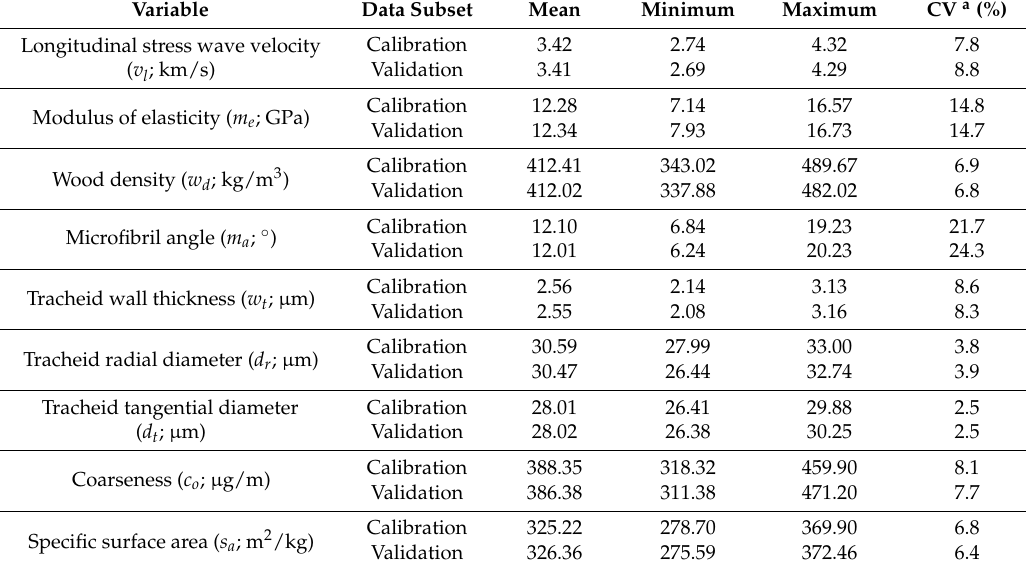
Table 6. Descriptive statistical summary of the calibration ( n = 122 logs) and validation ( n = 121 logs) data